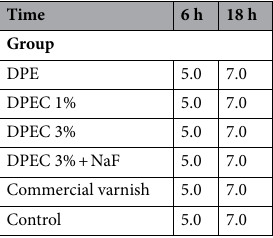
Table 5. Biofilm supernatant pH readings.